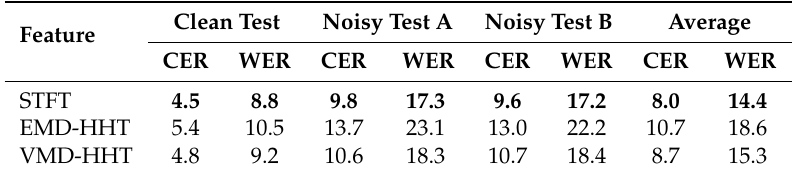
Table 3. Character error rate (CER) and word error rate (WER) results (%) of clean and noisy tests for single-feature models trained on the WSJ dataset (The best results for each set are highlighted with bold